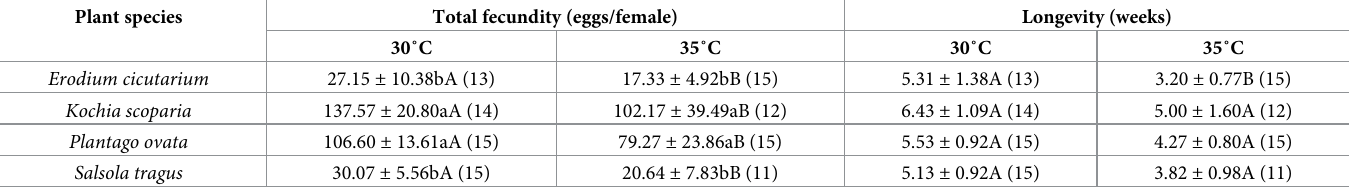
Different lowercase letters (a-b) indicate significant differences in total fecundity of beet leafhoppers on different plant species under the same temperature. There was no significant difference in longevity on different plant species under the same temperature. Different capital letters (A-B) indicate significant differences in total fecundity or longevity of beet leafhoppers at different temperatures within the same plant species. Values in parentheses are sample sizes.